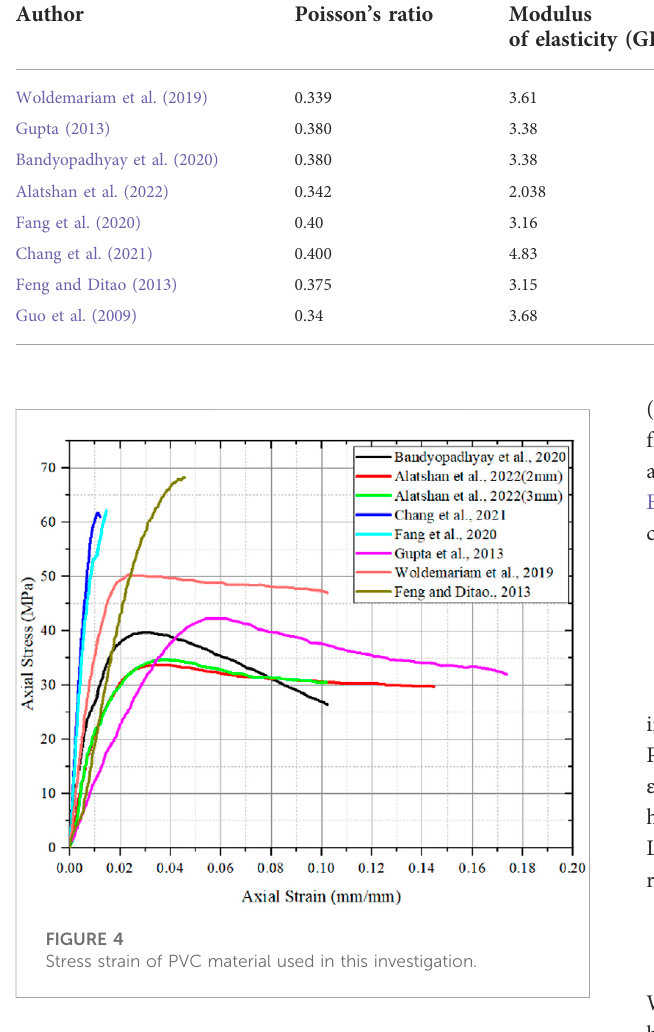
Where, s ’ is the clear spacing between hoop reinforcement, d cor is the diameter of con fi ned concrete core measured to the outside of hoop reinforcement and ρ is the longitudinal steel ratio relative cc to the con fi ned core concrete. Commonly, the ratio of the peak